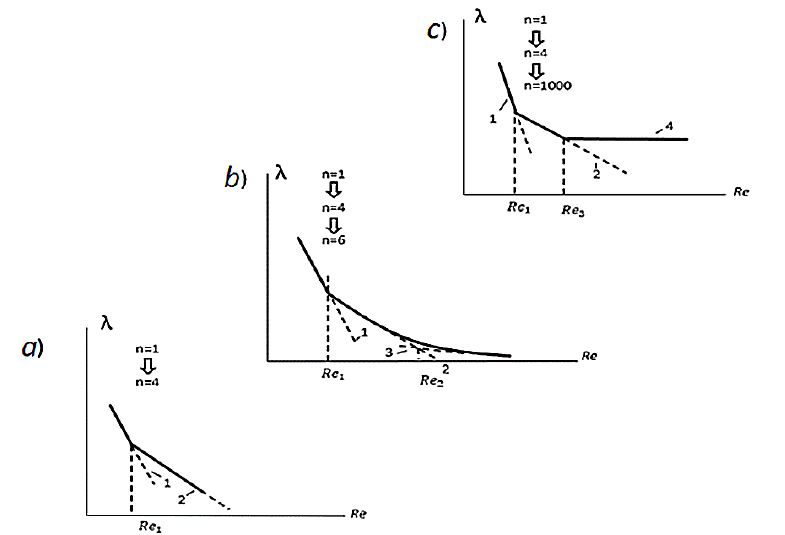
Figure 1. Resistance curves for different cases of flow of the n th power: ( a ) shows the transition from a laminar flow regime to a turbulent one; ( b ) shows this transition to the Prandl–Nikuradze curve; ( c ) shows the transition of curve 2 to curve 4 with a horizontal